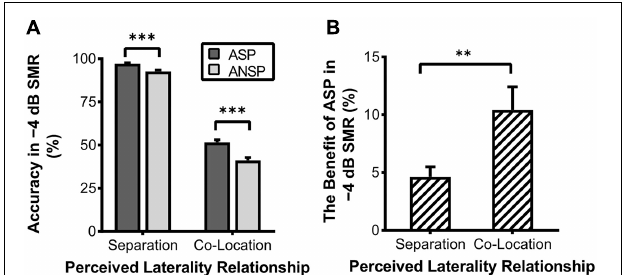
FIGURE 2 | Accuracy of recognition of the last keyword in target phrases under the − 4 dB SMR in the behavioral testing. (A) Comparisons of recognition accuracy under different priming types and perceived laterality relationships. (B) The enhanced recognition accuracy obtained through ASP against ANSP under different relationships of perceived laterality. The error bars represent standard errors. ∗∗∗ p < 0.001, ∗∗ p <